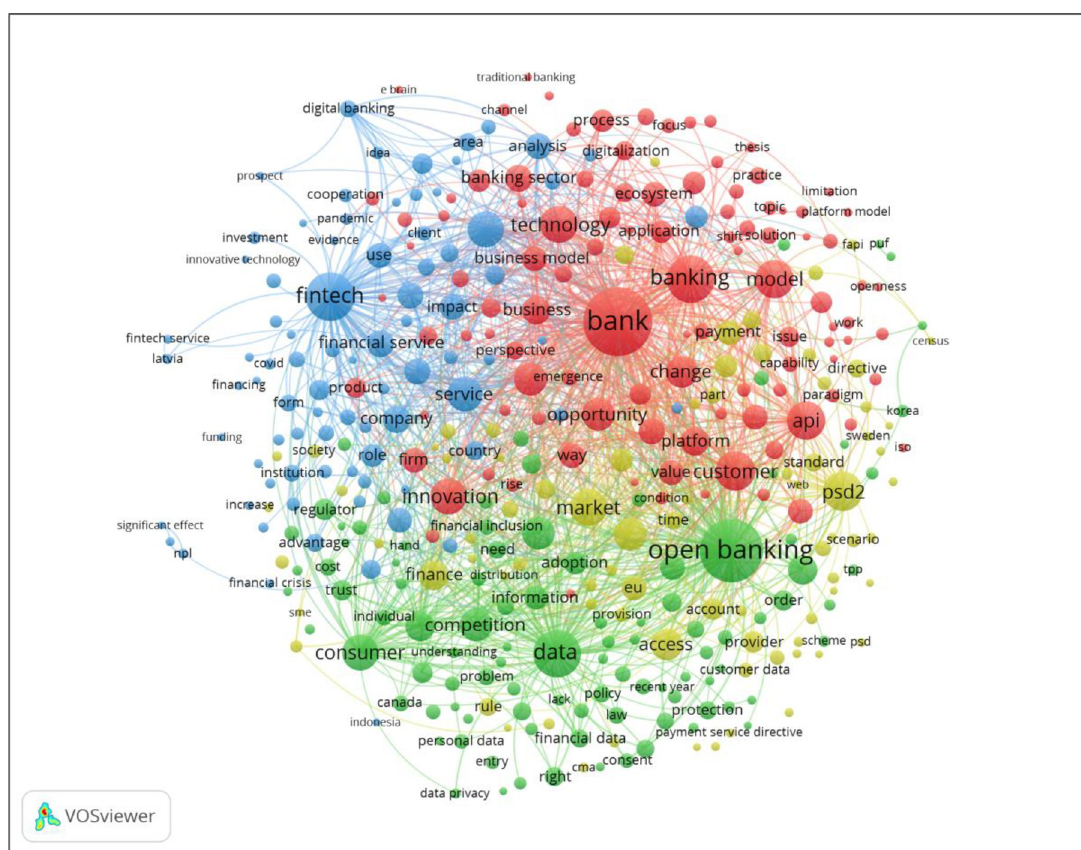
Fig 6. Graphical cluster representation.